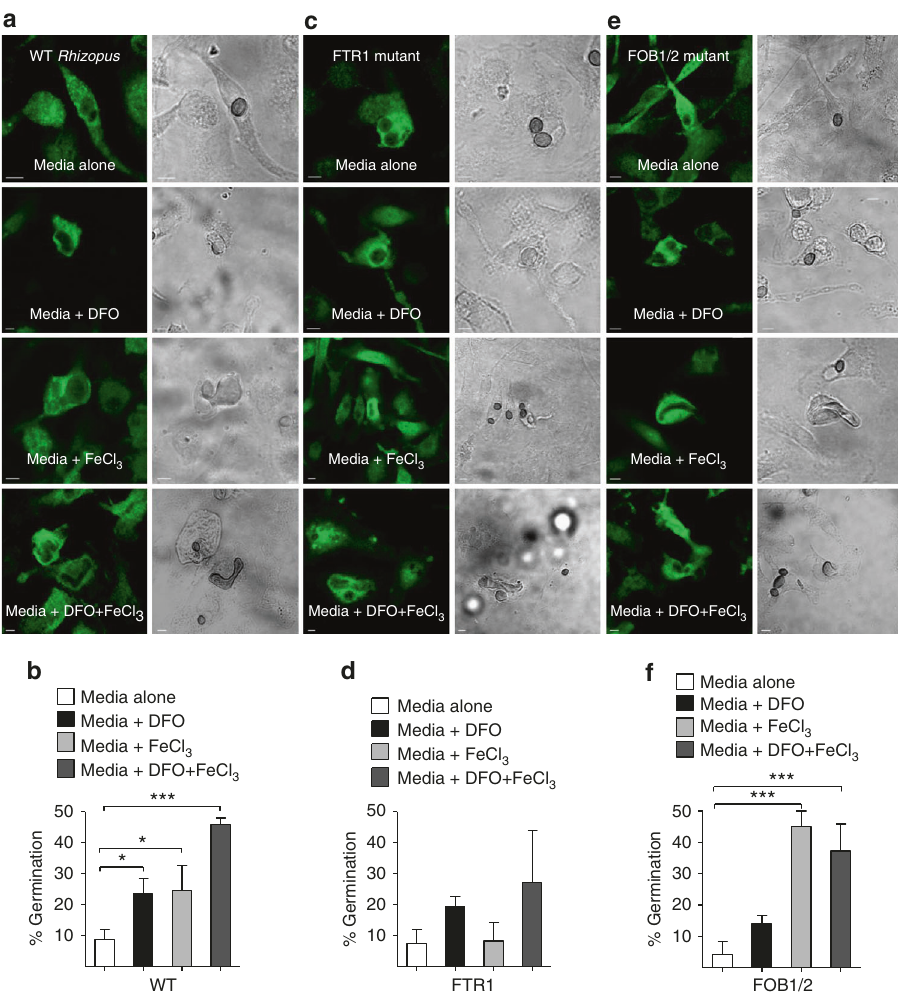
Fig. 8 Macrophages inhibit intracellular growth of Rhizopus via iron starvation. a , b BMDMs from GFP-LC3 mice were infected with WT Rhizopus delemar strain at an MOI of 1:2 (effector:fungal cells) in regular culture media or media containing DFO (100 μ M), iron (FeCl 3 ; 100 μ M), or DFO plus iron. At 1 h of infection, cells were extensively washed to remove non-phagocytosed conidia, media were replaced, and intracellular germination was assessed at 12 h by confocal imaging. BMDMs from GFP-LC3 mice were also infected with R. delemar -attenuated mutants for FTR1 ( c , d ) or FOB1/2 ( e , f ), which are defective in the high af fi nity iron permease expression regulating iron assimilation under conditions of limited iron availability and DFO receptor FOB1/2 mediating fungal iron uptake from DFO, respectively, as in a . The attenuated mutants were derived from the wild-type strain used in a , b by RNAi 9, 10 . Representative immuno fl uorescence images are shown in a , c , and f . Data on quanti fi cation of germination of intracellular conidia of the indicated Rhizopus strain are presented as mean ± SEM of three independent experiments. *** P < 0.0001, * P < 0.01, Mann – Whitney test. Bar, 5 µ